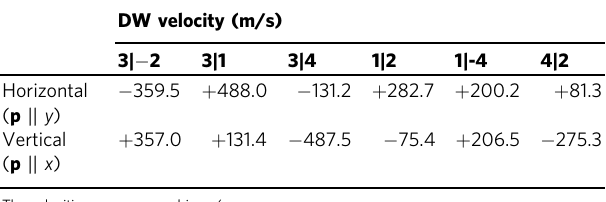
Table 1 Velocity of the six stable DW con fi gurations when a current density of 50 MA/cm 2 is applied along the vertical and horizontal arms of the